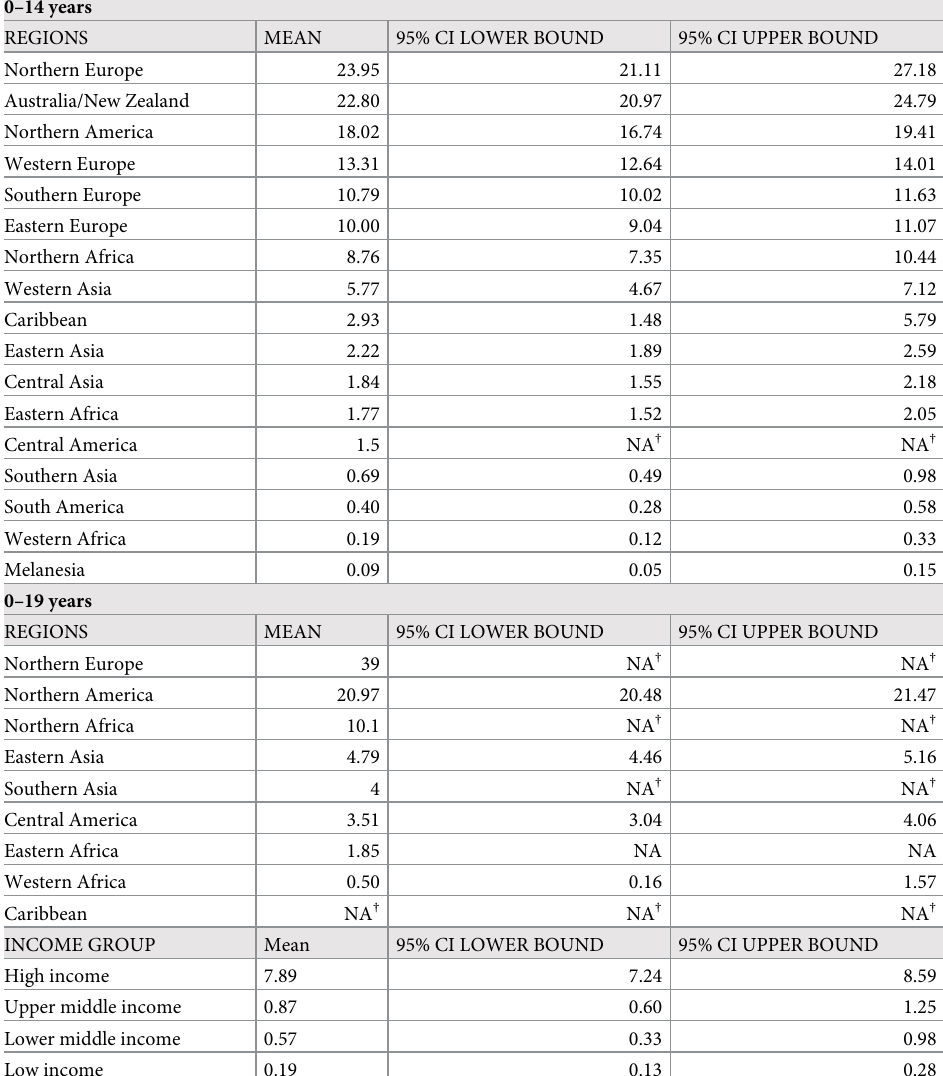
Table 1. Type 1 diabetes incidence rates in individuals aged 0–14 and 0–19 years by WHO regions and income. � (Age-standardised incidence rates per 100,000 individuals per year with 95% confidence intervals. † For cells labeled as NA, 95% CIs could not be estimated as there was only 1 data